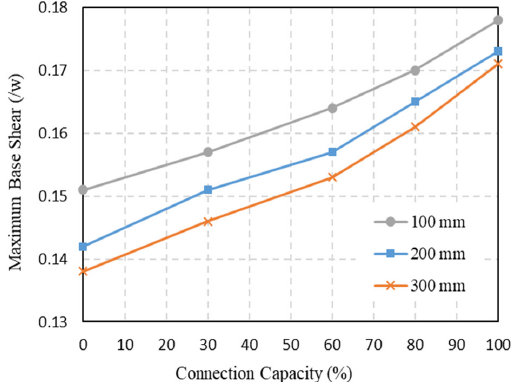
Figure 27. Maximum base shear of 10-story frame subjected to 5 earthquake records.